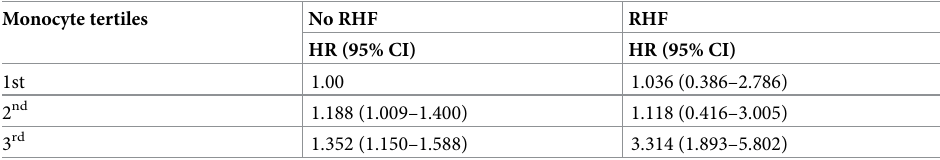
Risks are adjusted by age, sex, systolic blood pressure, body mass index, estimated glomerular filtration rate, hemoglobin, aspartate transaminase, aspartate aminotransferase, total cholesterol, diabetes, hypertension, malignancy, and coronary artery